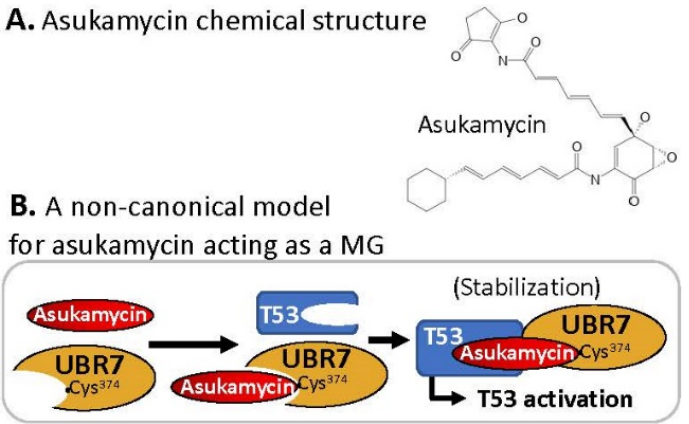
Figure 10. ( A ) Chemical structure of the non-canonical MG compound asukamycin; ( B ) asukamycin-mediated covalently engaged TP53/p53-UBR7 formation models.